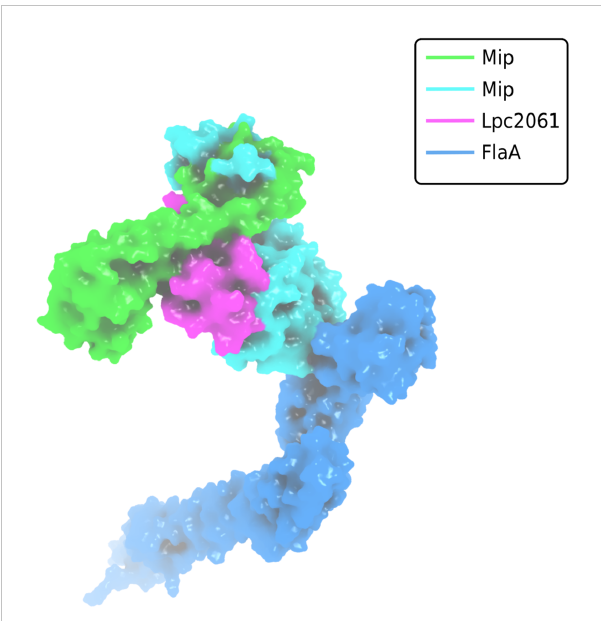
FIGURE 6 Surface plot visualization of the tripartite complex of Mip, FlaA and Lpc2061. Modeling was perfomed by docking of FlaA (marine blue) to the best pose of Lpc2061 (magenta) and the Mip homodimer (green and cyan). While Lpc2061 binds to the Mip dimerization region, monomeric FlaA interacts with the C-terminus of the PPIase domain. This tripartite complex was found to be more stable than the binary Mip-Lpc2061 interaction (Karagöz et al.,